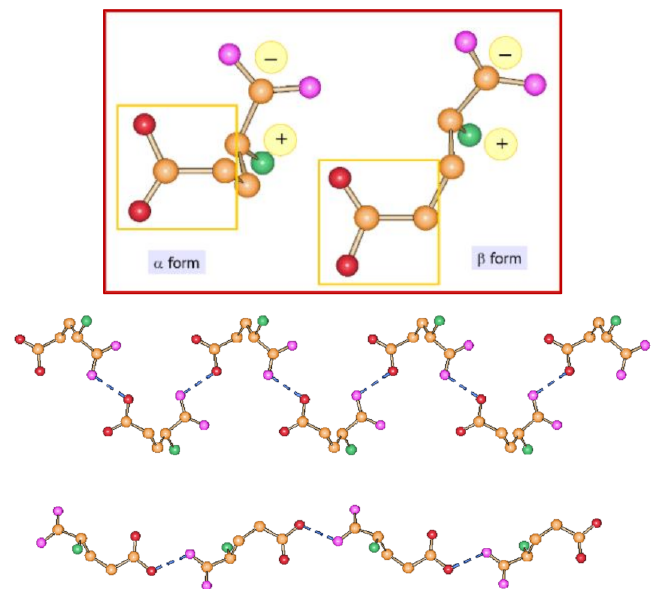
Figure 8. ( Top ) The α and β forms of L-glutamic acid and a comparison of the hydrogen bonded chains in the α ( middle ) and β ( bottom )